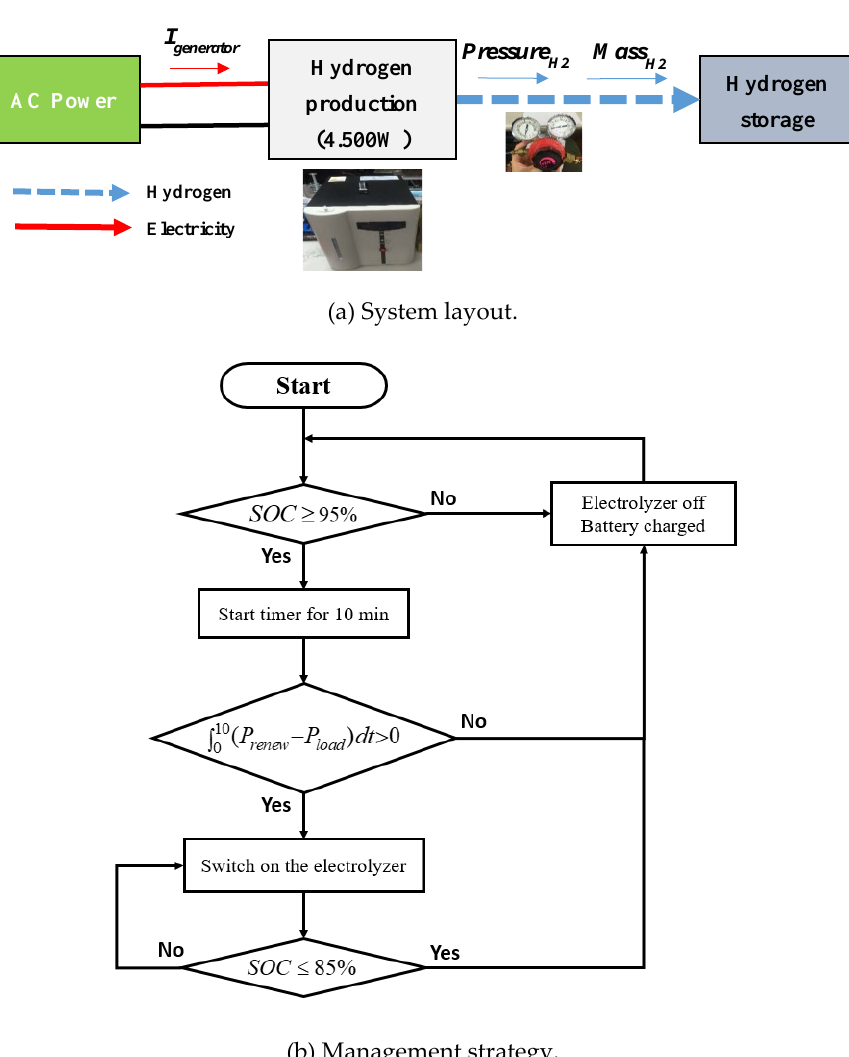
Figure 4. The hydrogen electrolyzation system.